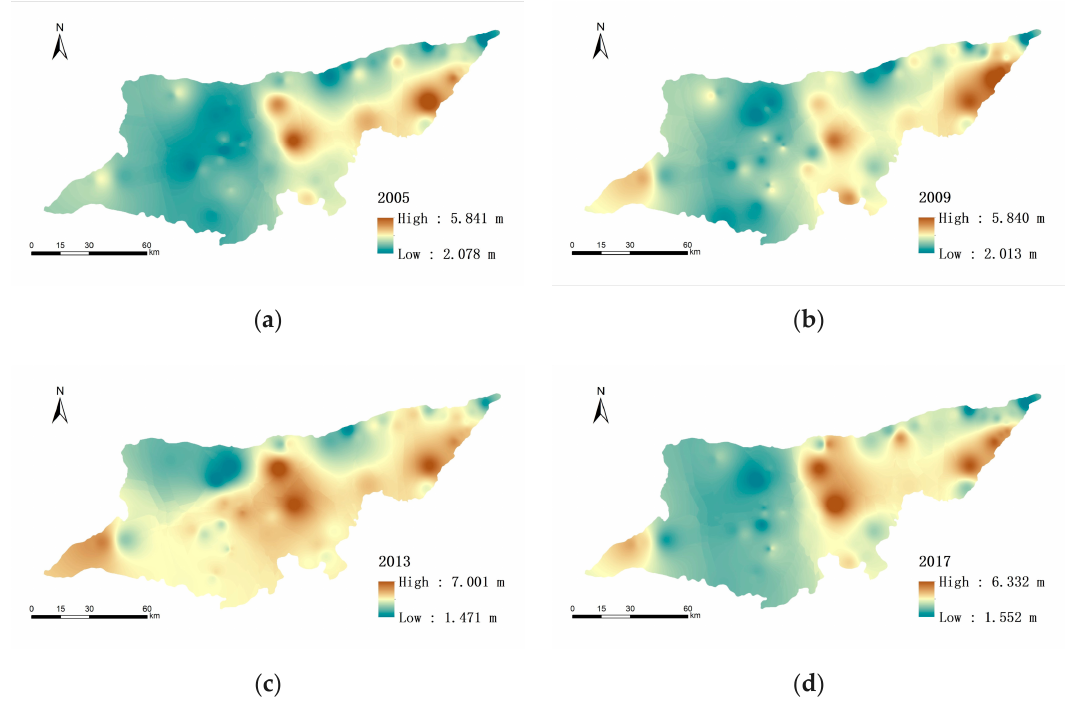
Figure 5. Ordinary kriging interpolation result in ( a ) 2005, ( b ) 2009, ( c ) 2013, ( d ) 2017.